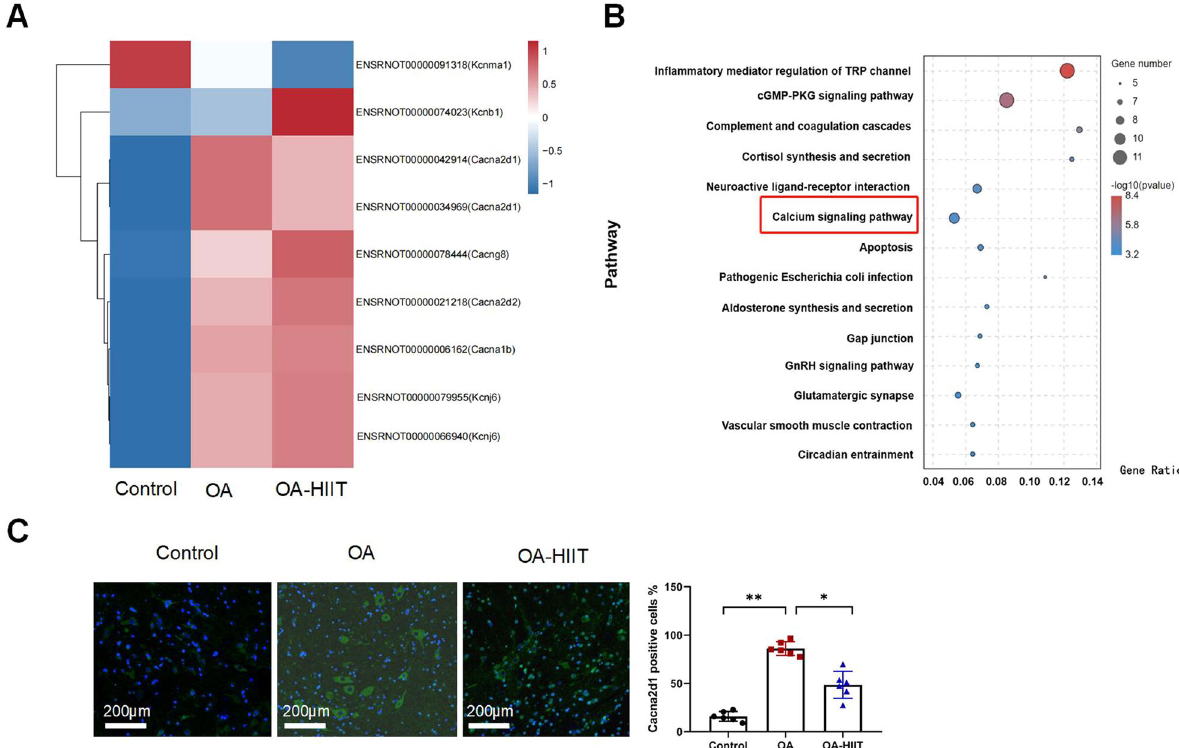
Fig. 2 HIIT decrease Cacna2d1 expression in OA rats. A Heat map analysis of the differential proteins in control rats, OA rats, and OA-HIIT rats. B KEGG pathway enrichment analysis of differential pathways. C Representative images of immunofluorescence (scale bar analyses of Cacna2d1 in the posterior horn of the spinal cord. Blue is stained for the nucleus, and green are marker proteins. n analysis of variance was used for comparisons between groups, the Tukey and LSD tests method was used as a post hoc test. * P < 0.05, ** P < 0.01 as